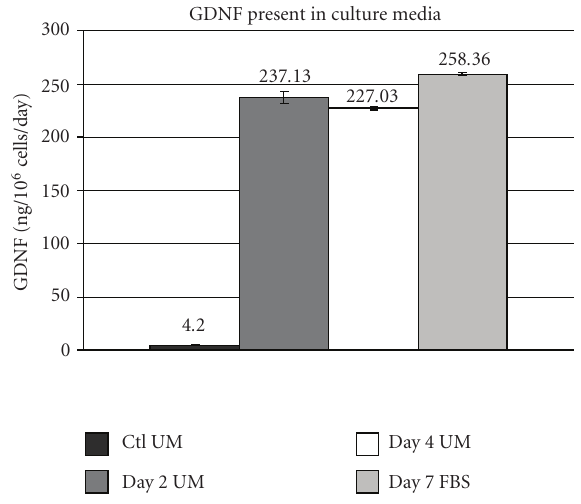
Figure 5: E ff ect of cell di ff erentiation on transgene GDNF expres- sion by ELISA. Lenti-GDNF-GFP vector transduced cNPCp24 cells were seeded equally in either UM (proliferation conditions) or Ultraculture-based medium without additional growth factors but containing 10% FBS (di ff erentiation conditions,